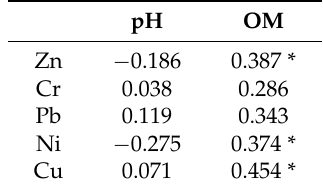
Table 3. Pearson correlations between heavy metals and physicochemical